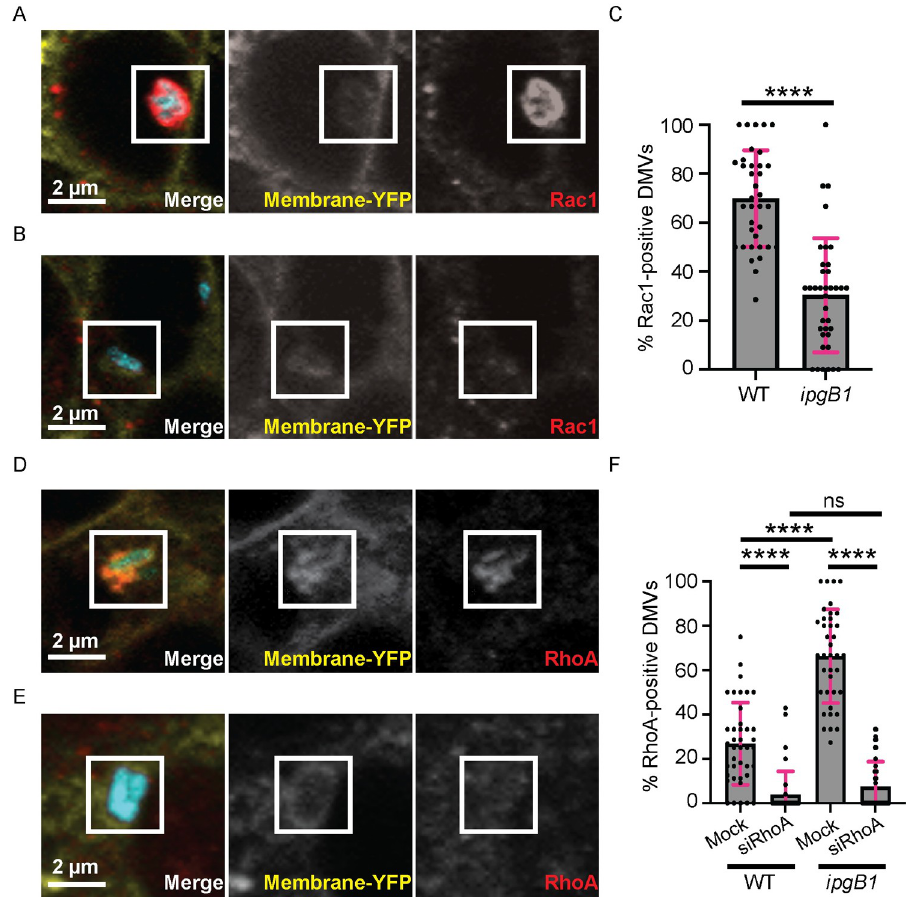
Fig 6. IpgB1 enhances Rac1 and antagonizes RhoA recruitment to DMVs. (A and B) Confocal images of HT-29 cells stably expressing plasma membrane-targeted YFP and infected for 5 hr with CFP-expressing S . flexneri and stained using an anti-Rac1 antibody followed by AlexFluor 594-conjugated anti-mouse secondary antibody. Merged images are shown on the left, single YFP channel in middle, and single mCherry channel on the right. Scale bar, 2 μ m. (A) Representative example of a DMV that is positive for Rac1 recruitment. (B) Representative example of a DMV that is negative for Rac1 recruitment. (C) Quantification of the percentage of wild type or ipgB1 DMVs per foci associated with Rac1 HT-29 cells. Each dot represents the percent Rac1-positive DMVs in an infection focus and the grey bars show the mean percentage of Rac1-positive DMVs from all foci measured in three biological replicates. (D and E) Confocal images of HT-29 cells stably expressing plasma membrane-targeted YFP and infected for 5 hr with CFP- expressing S . flexneri and stained using an anti-RhoA antibody followed by AlexFluor 594-conjugated anti-mouse secondary antibody. Merged images are shown on the left, single YFP channel in middle, and single mCherry channel on the right. Scale bar, 2 μ m. (D) Representative example of a DMV that is positive for RhoA recruitment. (E) Representative example of a DMV that is negative for RhoA recruitment. (F) Quantification of the percentage of wild type or ipgB1 DMVs per foci associated with RhoA in either mock-treated or RhoA duplex 2-depleted HT-29 cells. Each dot represents the percent RhoA-positive DMVs in a focus and the grey bars show the mean percentage of RhoA- positive DMVs from all foci measured in three biological replicates. At least twelve foci per condition were analyzed in each biological replicate. Error bars indicate standard deviation. One-way ANOVA with Tukey’s multiple comparisons; ns, not significant; ���� , p < 0.0001. RhoA-positive (Fig 6F, WT, mock). Strikingly, we observed a dramatic increase in the percent- age of RhoA-positive DMVs in cells infected with the ipgB1 mutant (Fig 6F, ipgB1 , mock). RhoA knockdown significantly decreased the percentage of RhoA-positive DMVs observed in cells infected with the ipgB1 mutant to wild type levels (Fig 6F, siRhoA). These results are in agreement with the notion that IpgB1 supports DMV escape by antagonizing RhoA recruit- ment to DMVs.